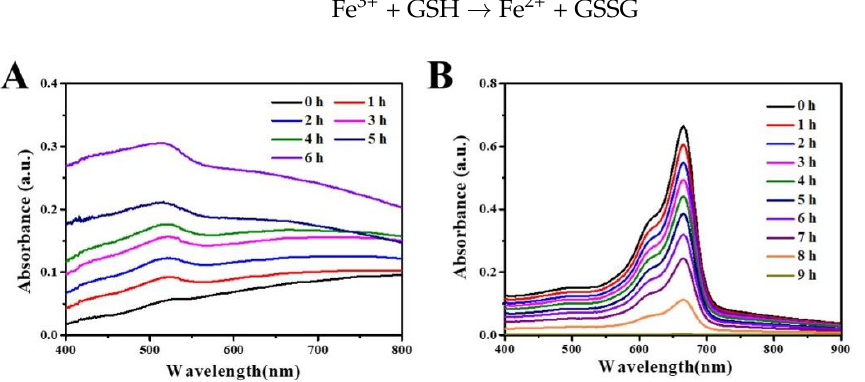
Figure 3. Degradation curves of ( A ) o -diphenanthrene and ( B ) MB by Fe 3 O 4 @Au/PPy dispersions at various times (h).